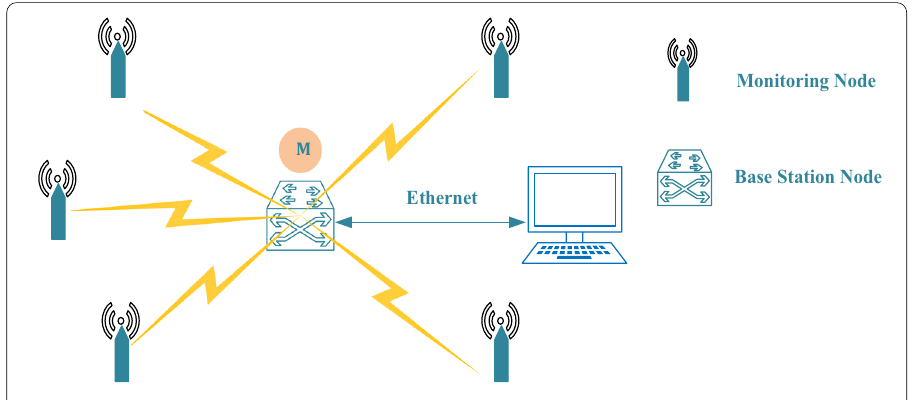
Fig. 1 Structure diagram of a single wireless star network monitoring hardware